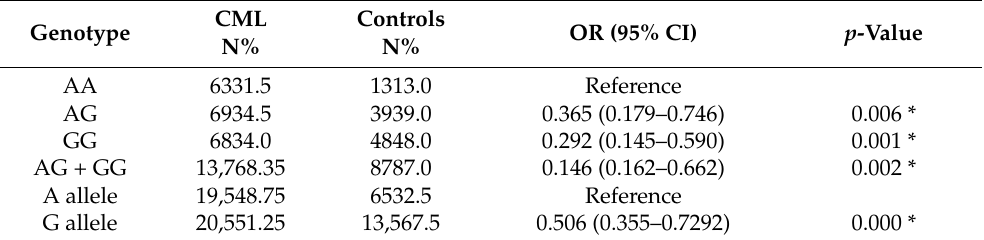
Table 2. Comparing alleles and genotypes of MTRR A66G between CML patients and